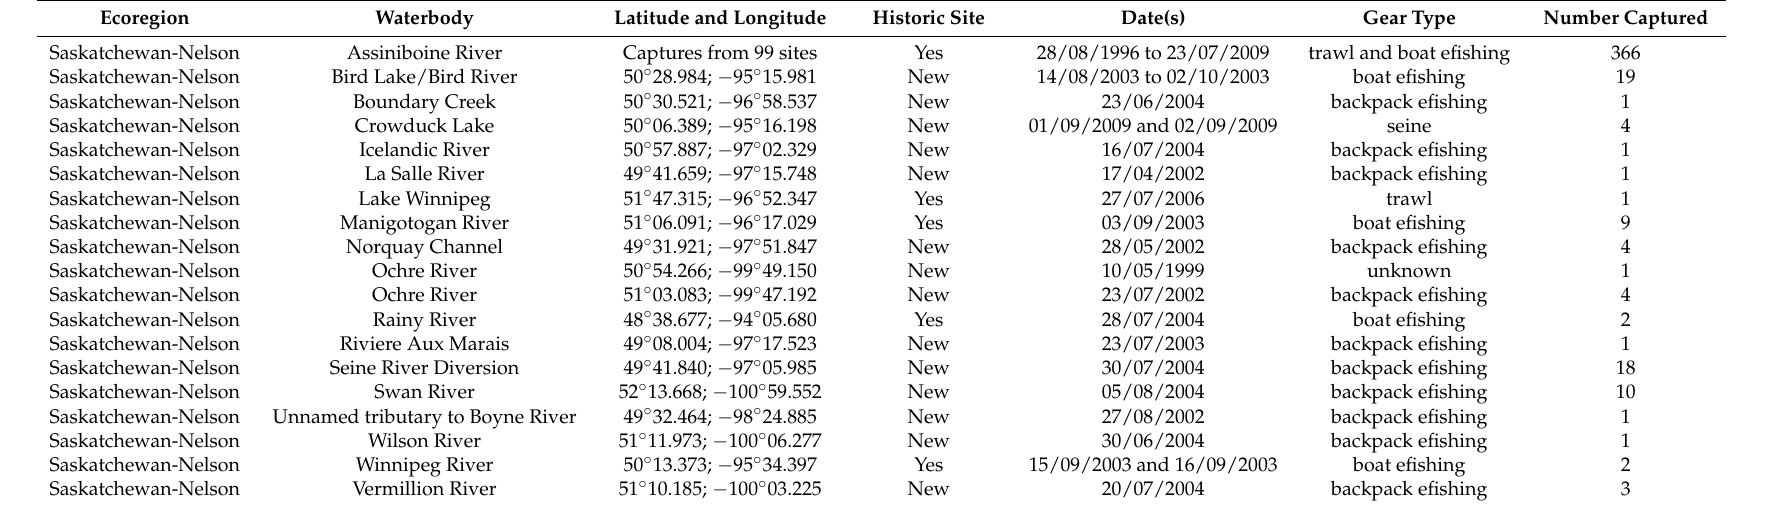
Table 1. Sampling site and date, ecoregion, gear type, and the number of River Darters captured by DFO for surveys where River Darters were incidentally captured. Whether River Darters were previously found at that site is also